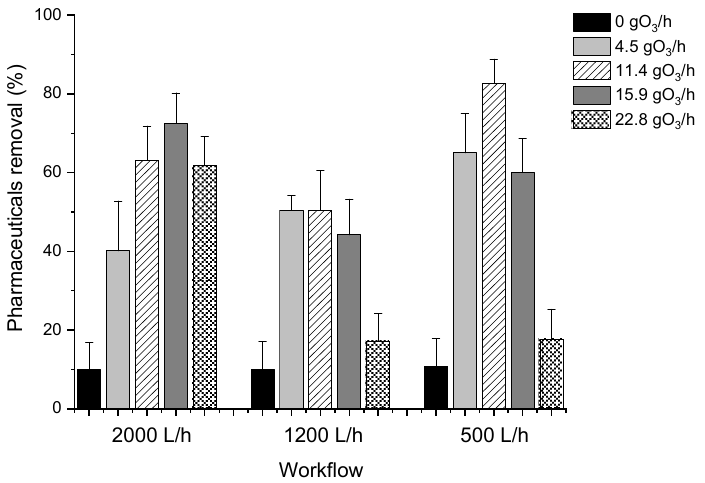
Figure 1. Influence of inlet ozone concentration and flow rate in pharmaceuticals removal. A clear relationship was also observed between the pharmaceutical removal percent- ages and ozone production, according to Dawood et al., 2021 [29]. In particular, an increase in the ozone dose applied was related to an increase in pharmaceuticals removal, reaching maximum values of 72.5 ± 7.8% working with 15.9 gO 3 /h, 50.3 ± 10.2% working with 11.4 gO 3 /h and 82.7 ± 6.2% working with 11.4 gO 3 /h, when 2000 L/h, 1200 L/h, and 500 L/h workflow were tested, respectively. However, a decrease in removal efficiency was observed in all cases when working at maximum ozone production values (22.8 gO 3